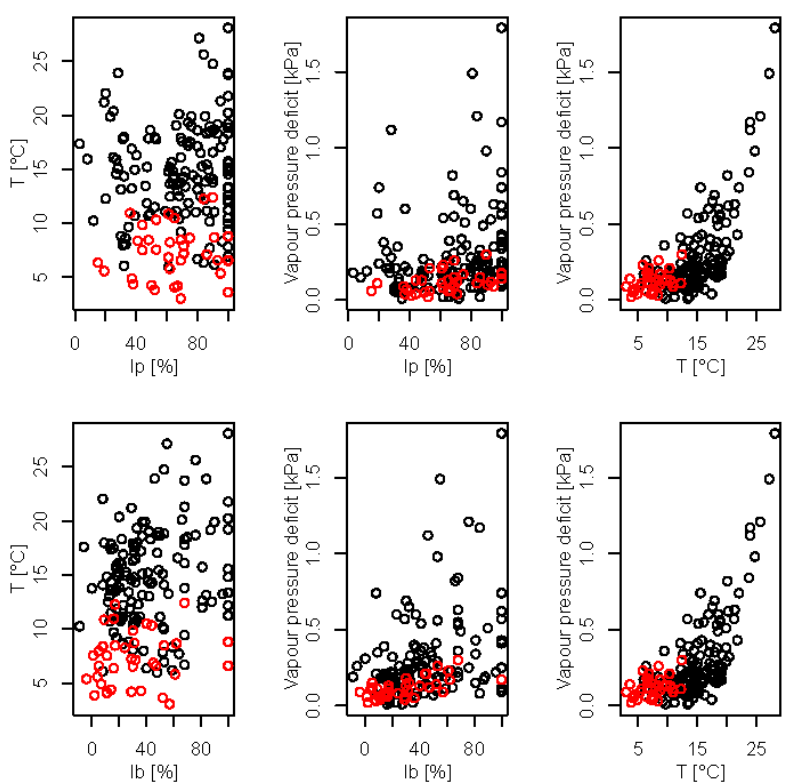
Figure 2. Graphical presentation of the relationship among interception loss for pine trees ( Ip ), vapour pressure deficit and air temperature ( T ) (upper panel) and interception loss for birch trees ( Ib ), vapour pressure deficit and air temperature ( T ) (lower panel). Events measured in the leafless and leafed period are indicated with red and black colour, respectively.